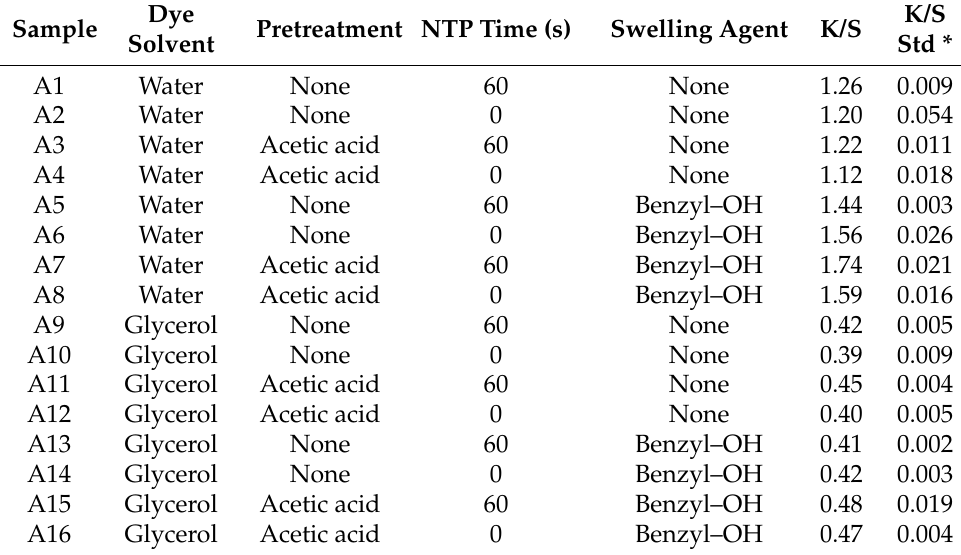
Table 1. Experiment A: experimental design and results @